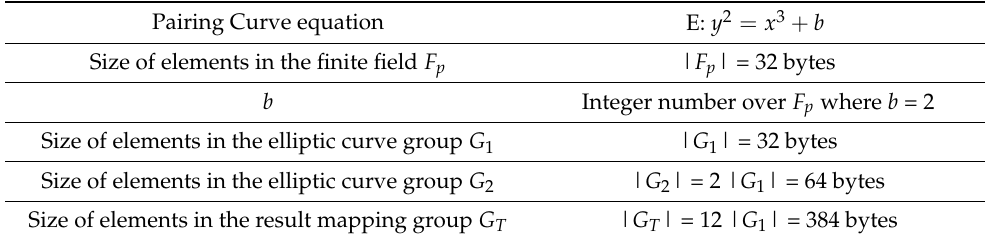
Table 3. The BN256 bilinear pairing curve parameters. Pairing Curve